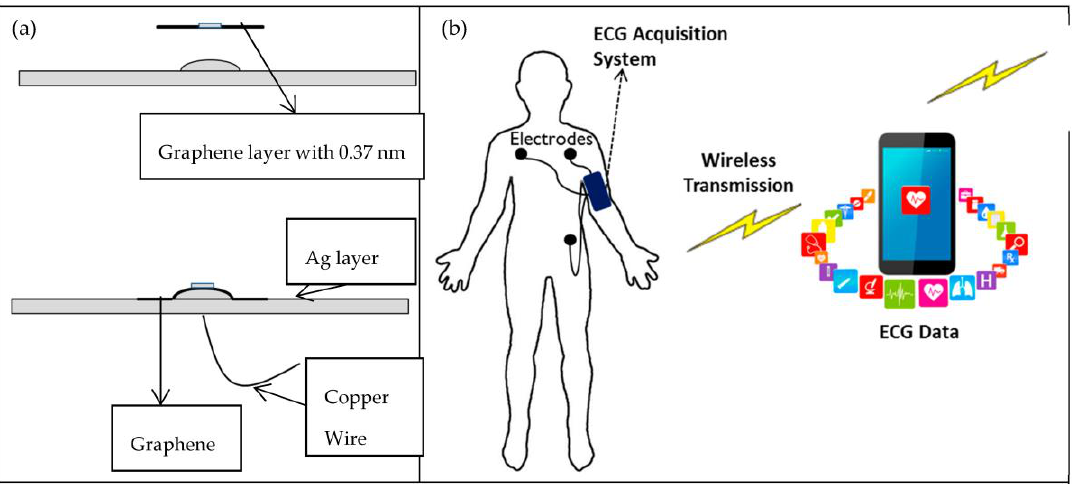
Figure 5. The graphene-electrode mechanism: ( a ) The mechanism of graphene-coated electrode; ( b ) the schematic illustration of the developed system while ear-lead electrocardiogram (ECG) was tested on the subject, including a wireless ECG data acquisition system.